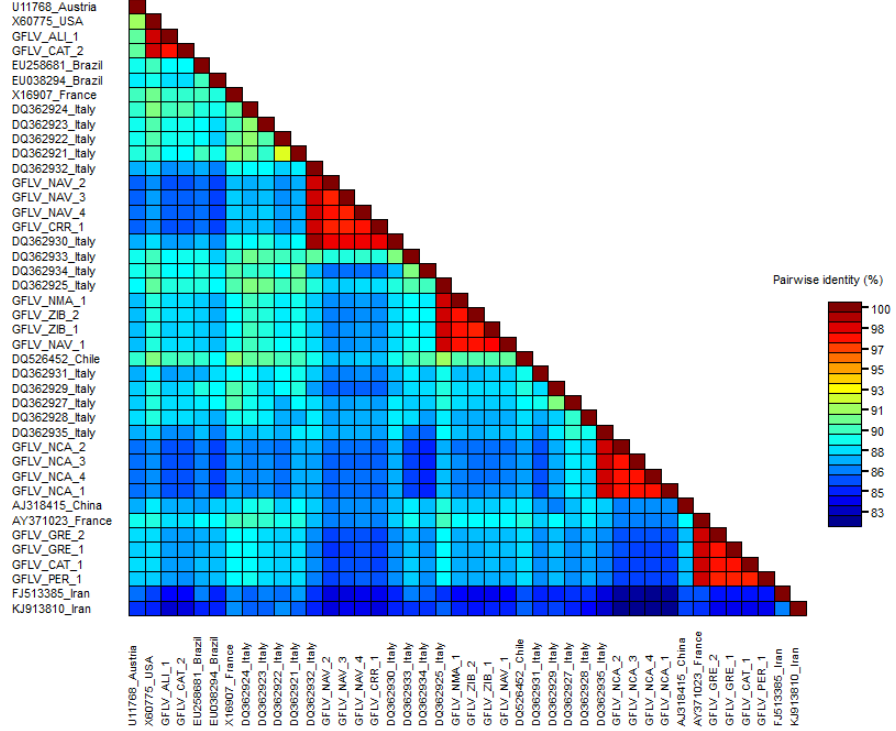
Figure 4. Graphical representations of pairwise percent identity of nucleotides of the sequenced coat protein gene between the GFLV isolates from Sicily (Italy) and reference isolates, using SDTv1.0 program. Each colored key represents a percentage for the identity score between two sequences.